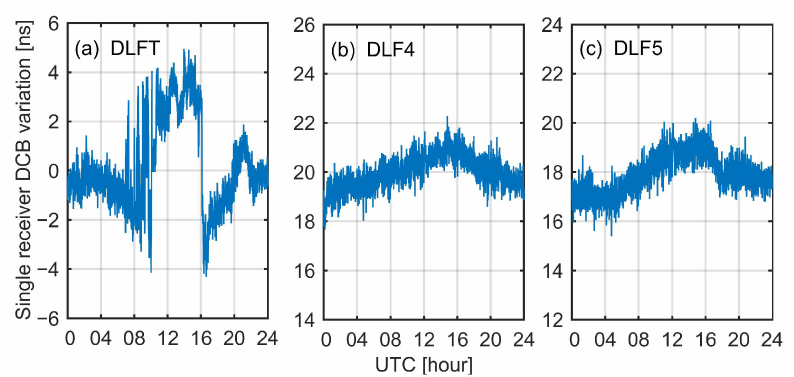
Figure 3. Epoch-by-epoch estimates of single-receiver DCBs retrieved using the MCCL plus datum method for three co-located receivers: DLFT, DLF4, DLF5 on DOY 172, 2010.